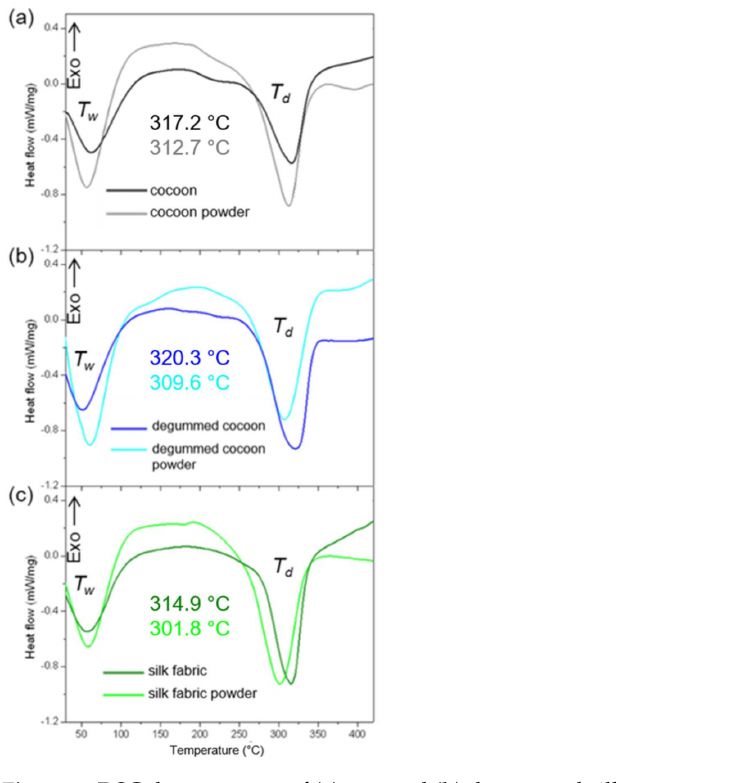
Figure 7. DSC thermograms of ( a ) raw and ( b ) degummed silk cocoons, and ( c ) silk fabric, and silk powders from ( a ) raw cocoons, ( b ) degummed cocoons, and ( c ) silk